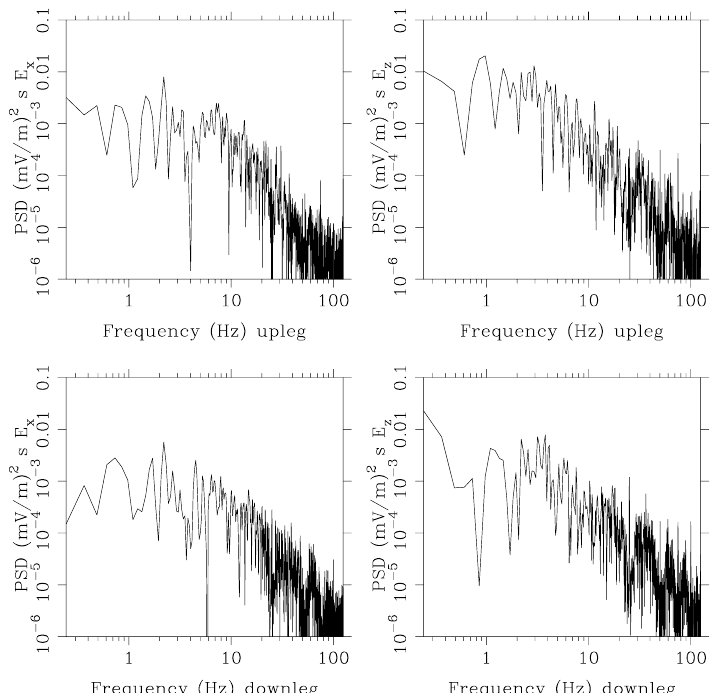
Fig. 15. Power spectra of the bottom-type layer electric fields measured on 15 August 2004. A frequency of 1Hz corresponds roughly to a wavelength of 1.8km.